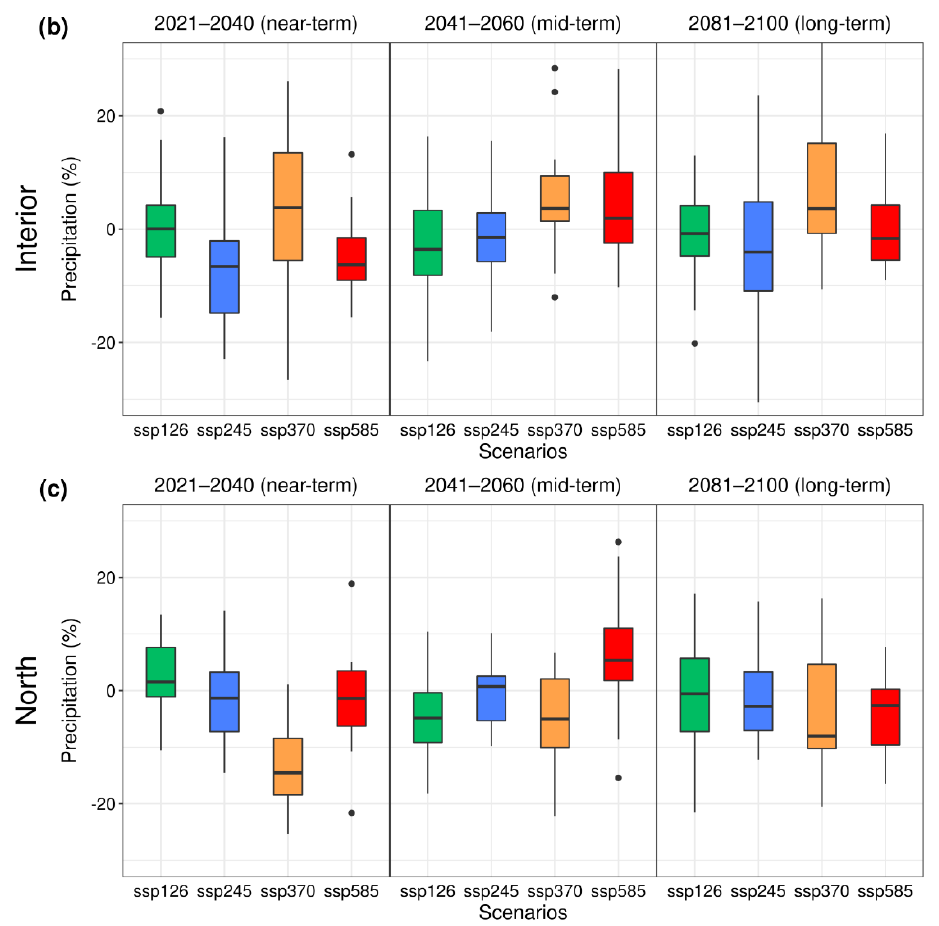
Figure 12. Boxplot of the relative change in precipitation CMIP6 for the near-term, mid-term, and long-term (end of the century) period: ( a ) East Coast, ( b ) Interior, and ( c ) North. The colored box plot corresponds to the average 5 best models (ensemble) of CMIP6 for the SSP1-2.6, SSP2-4.5, SSP3-7.0, and SSP5-8.5 scenarios.